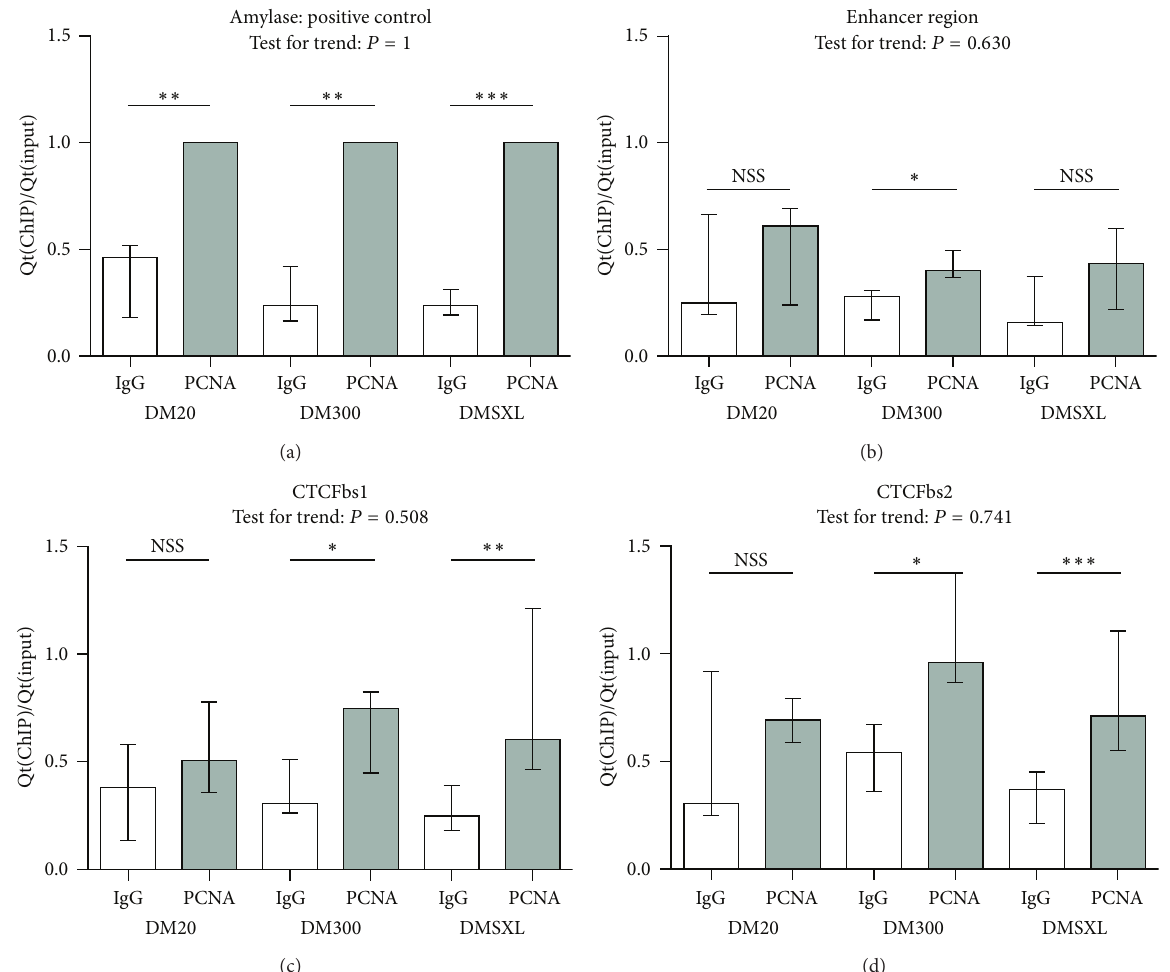
Figure 6: PCNA seems to bind to expanded CTG-repeats. CTCFbs1 and bs2, but not the enhancer region, show statistically significant enrichment of PCNA in abChIP versus IgG-IP in the expanded CTG-repeat length categories, but not at DM20, suggesting that PCNA binds the expanded CTG-repeat. These graphs show enrichment (Qt(IP)/Qt(input), normalised against the abCHIP enrichment value of the positive control amplicon of each respective repeat length category) for PCNA in abChIP versus IgG-IP at a positive control amplicon and three regions at the DM1 locus. Height of the bars indicates the median enrichment, and error bars indicate the interquartile range (25th to 75th percentile of observations). Mann-Whitney tests were performed to test for a statistically significant difference between the abChIP and IgG reactions. Results are summarised here with ∗ being 𝑃 < 0.05 , ∗∗ being 𝑃 < 0.01 , and ∗∗∗ being 𝑃 < 0.001 . Details of the statistical analysis can be found in Supplementary Table 1. The enrichment values obtained for the specific abChIP reactions were subjected to the Jonckheere Terpstra test for trend, which tests whether a trend exists across the categories with increasing CTG-repeat length. 𝑃 values are indicated in the graphs and details of this statistical analysis can be found in Supplementary Table